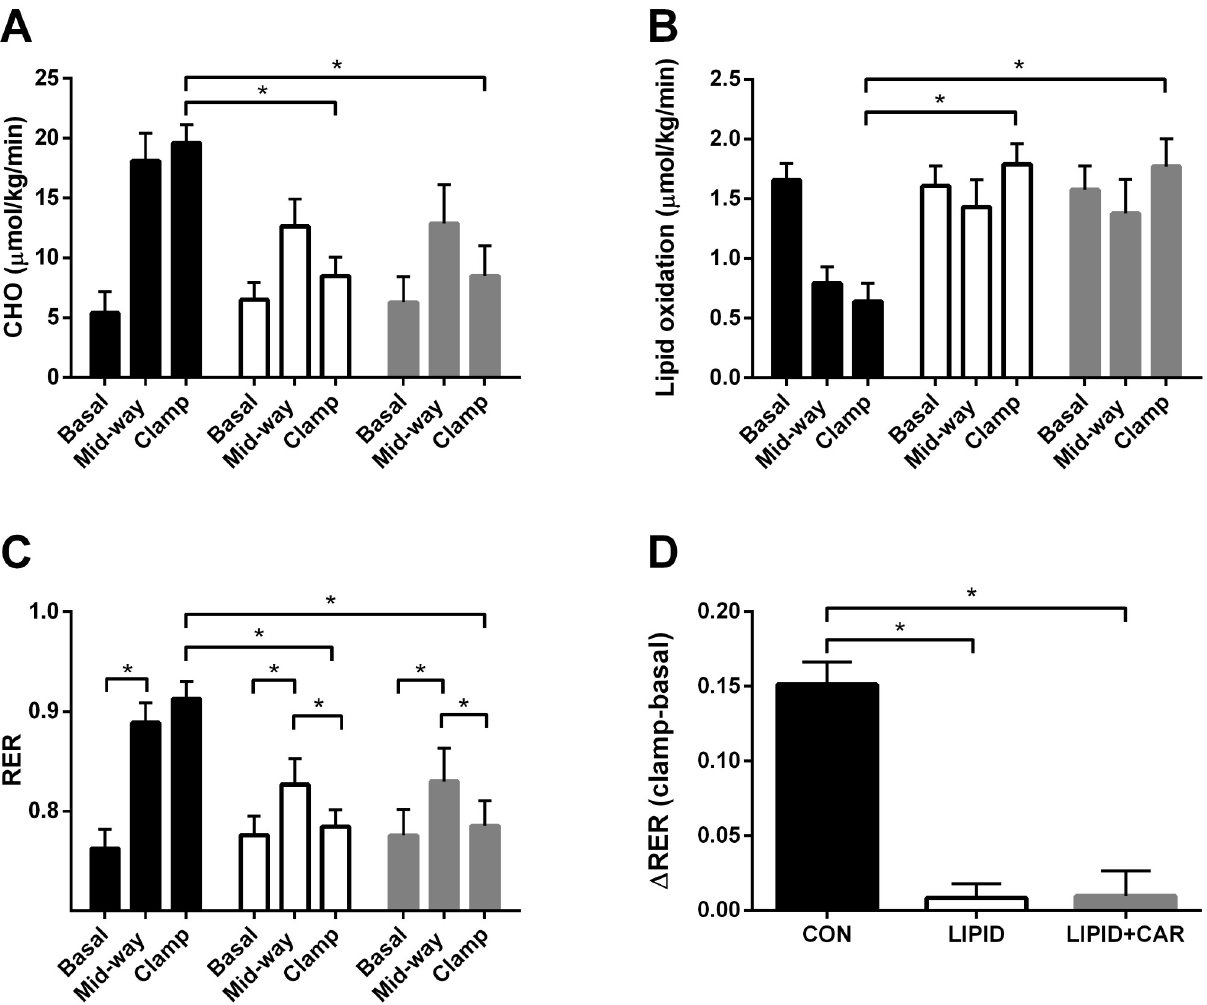
Fig 3. Metabolic flexibility and substrate oxidation. Glucose oxidation (A), Lipid oxidation (B), respiratory exchange ratio (RER) (C) and metabolic flexibility expressed as delta RER (D) assessed during a hyperinsulinemic-euglycemic clamp in CON, LIPID and LIPID+CAR (n = 8). Black bars represent CON, white bars LIPID and grey bars represent LIPID+CAR. Basal clamp is measured from t = -30-t = 0, mid-way from t = 120–150 and clamp from t = 330–360. Data are expressed as mean + SEM. � , Significantly different from CON ( P < 0.05).